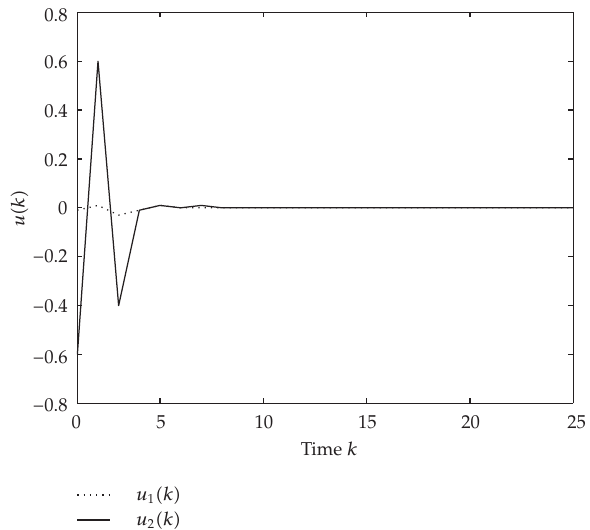
Figure 6: Control input of the switched discrete time